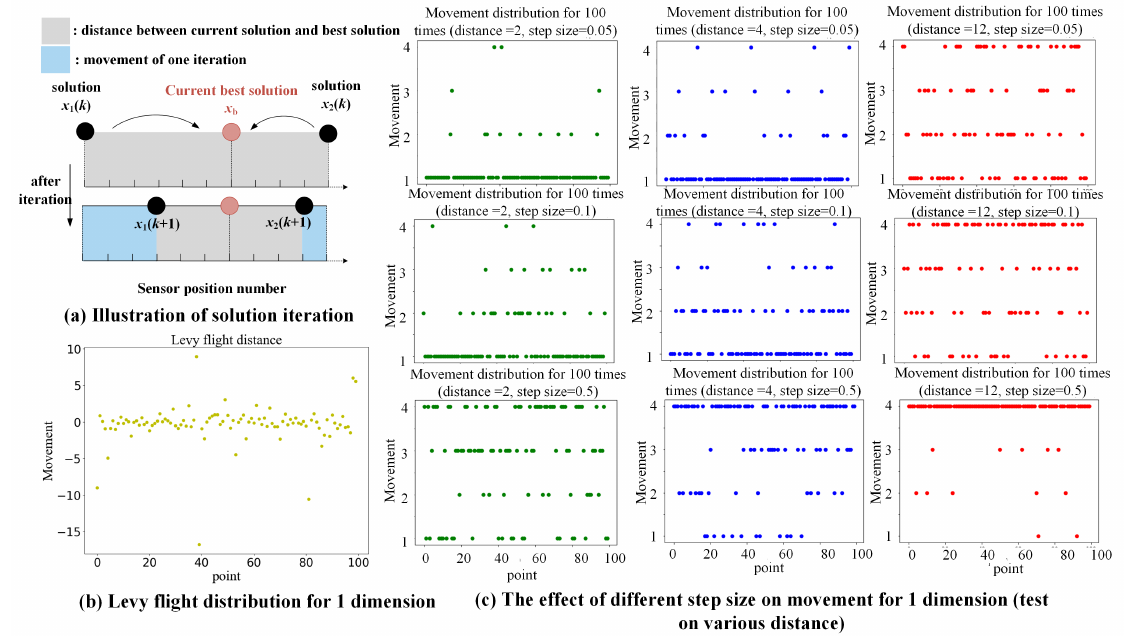
Figure 4. The distribution of adjustment of the solution regarding the scale factor in 100 iterations (the mapping operator is 4 as an example); ( a ) Illustration of the distance between the solution and the current best result, as well as the adjustment of each iteration; ( b ) the initial Levy flights distribution for adjustment during 100 times iteration; and ( c ) the influence of step size on different distance situations.